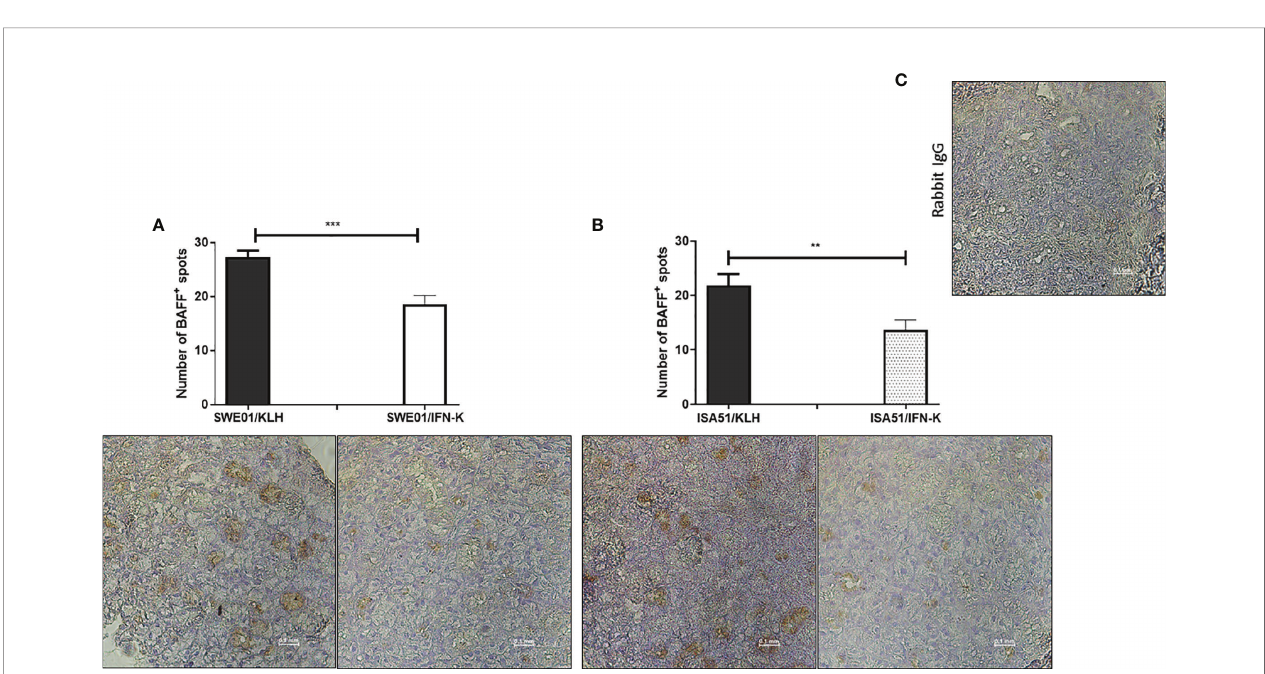
FIGURE 5 | Lacrimal histopathological features. Representative low (left; x10) and high (right; x40) magni fi cation images of hematoxylin and eosin-stained sections of the lacrimal glands harvested at the end of follow-up in SWE01/KLH (n=5), SWE01/IFN-K (n=6), ISA51/KLH (n=7) and ISA51/IFN-K (n=7) living mice, are shown.